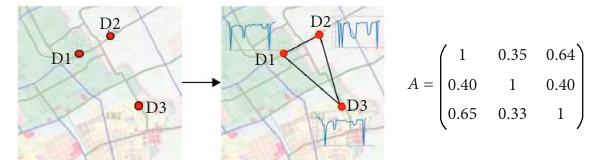
Figure 2: Construction of adjacency matrix by